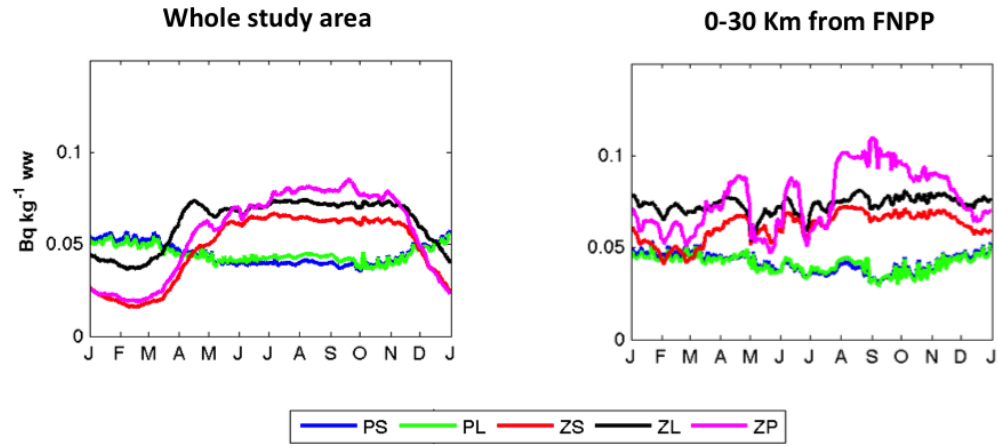
Figure 10. Dynamics of 137 Cs concentration in all plankton groups in the no-accident situation.